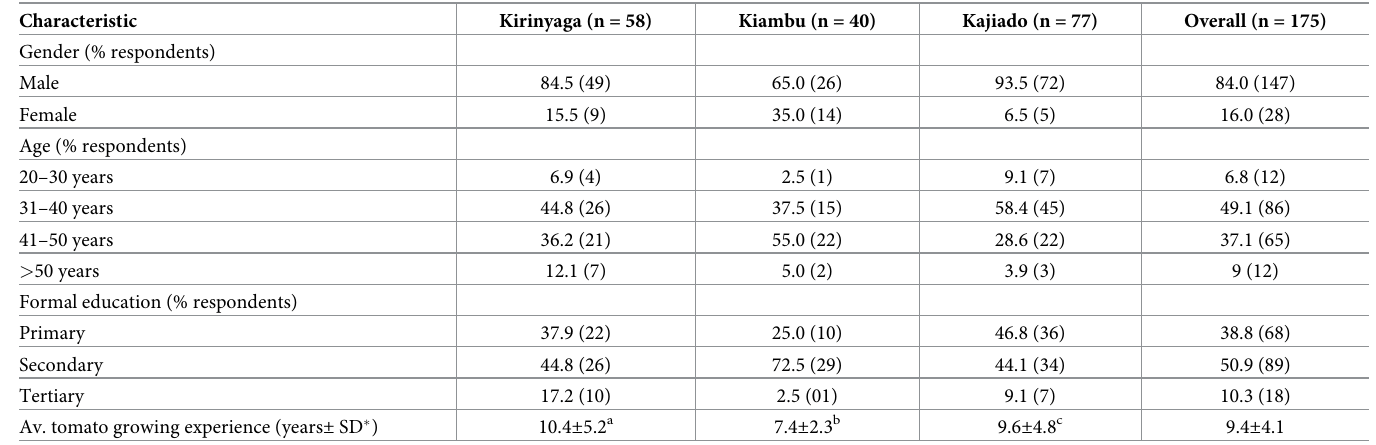
Figures in parentheses represent frequencies of the responses. � Standard deviation. Letters indicate significant differences between means at α =